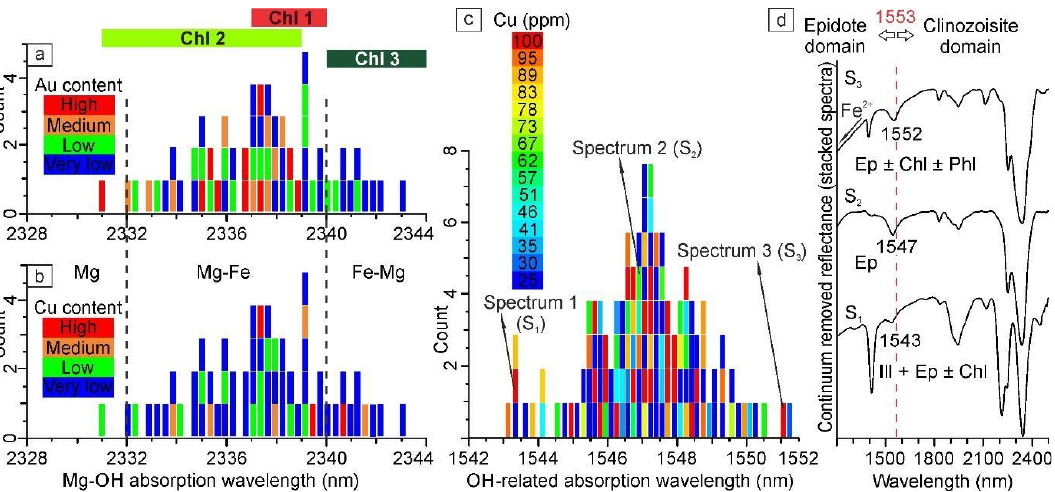
Figure 12. Chlorite and epidote spectral analysis of the Paraíba deposit. ( a ) Histogram of chlorite Mg-OH feature position. The colored bars above indicate the wavelength interval of each chlorite group. Note the high correlation among Mg-rich chlorite samples (Chl – 1 and Chl – 2) and high Au values. ( b ) Histogram of the chlorite Mg-OH feature position. Chlorite samples do not show high correlation with Cu-rich values. ( c ) Histogram with the ~1545nm wavelength position for all samples of the Paraíba deposit. Note the high correlation among epidote samples and high Cu grades. ( d ) Epidote reflectance spectra. Classification of epidote and clinozoisite is differentiated by the dashed line at 1553nm. Chl: chlorite; Ep: epidote; Ill: illite; Phl: phlogopite.